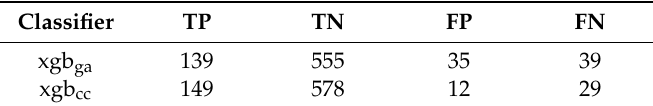
Table 10. Performance of best classifiers on training and test